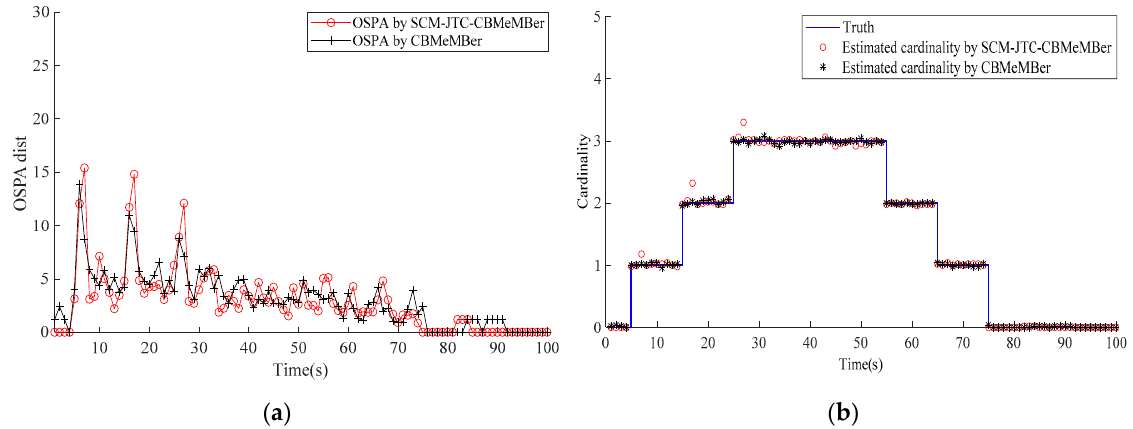
Figure 7. Estimated target state: ( a ) Optimal Subpattern Assignment (OSPA) distance; ( b ) the estimated cardinality.